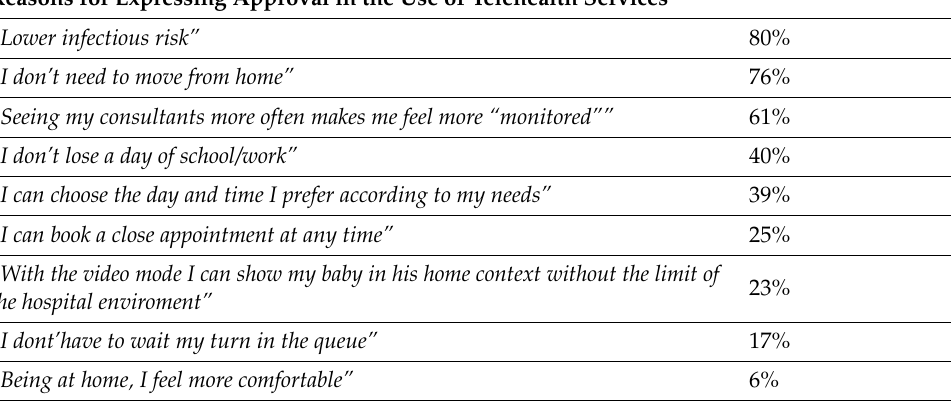
Table 2. Given the reasons for expressing approval in the use of telehealth services among patients affected by